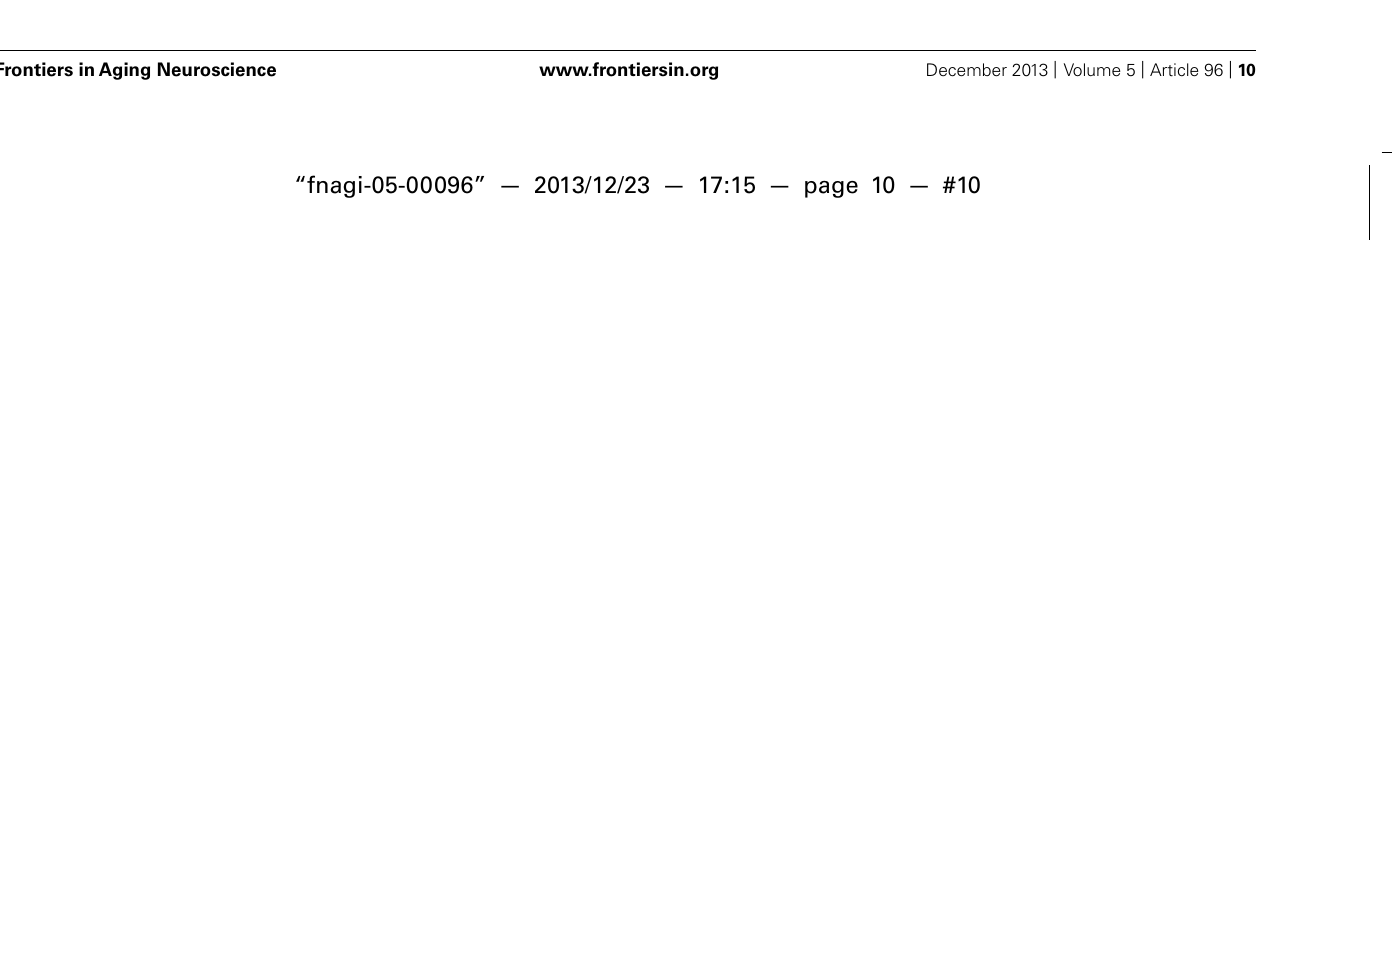
devoted to the exploration of the novel object in comparison to mice treated with vehicle. Data are the mean ± SEM ( n = 6–7 mice/group). ∗ p < 0.05, ∗∗ p < 0.01 versus familiar object (two-way ANOVA followed by Bonferroni’s test). (B) This finding was confirmed also by calculating the discrimination index [(novel − familiar)/(familiar + novel)]. Data are the mean ± SEM. Indices different from zero: ∗ p < 0.05, ∗∗ p < 0.01 (unpaired Student’s t test). § p < 0.05 versusTg-vehicle group (two-way ANOVA followed byTukey’s test). (C) The total exploration time was not significantly different among